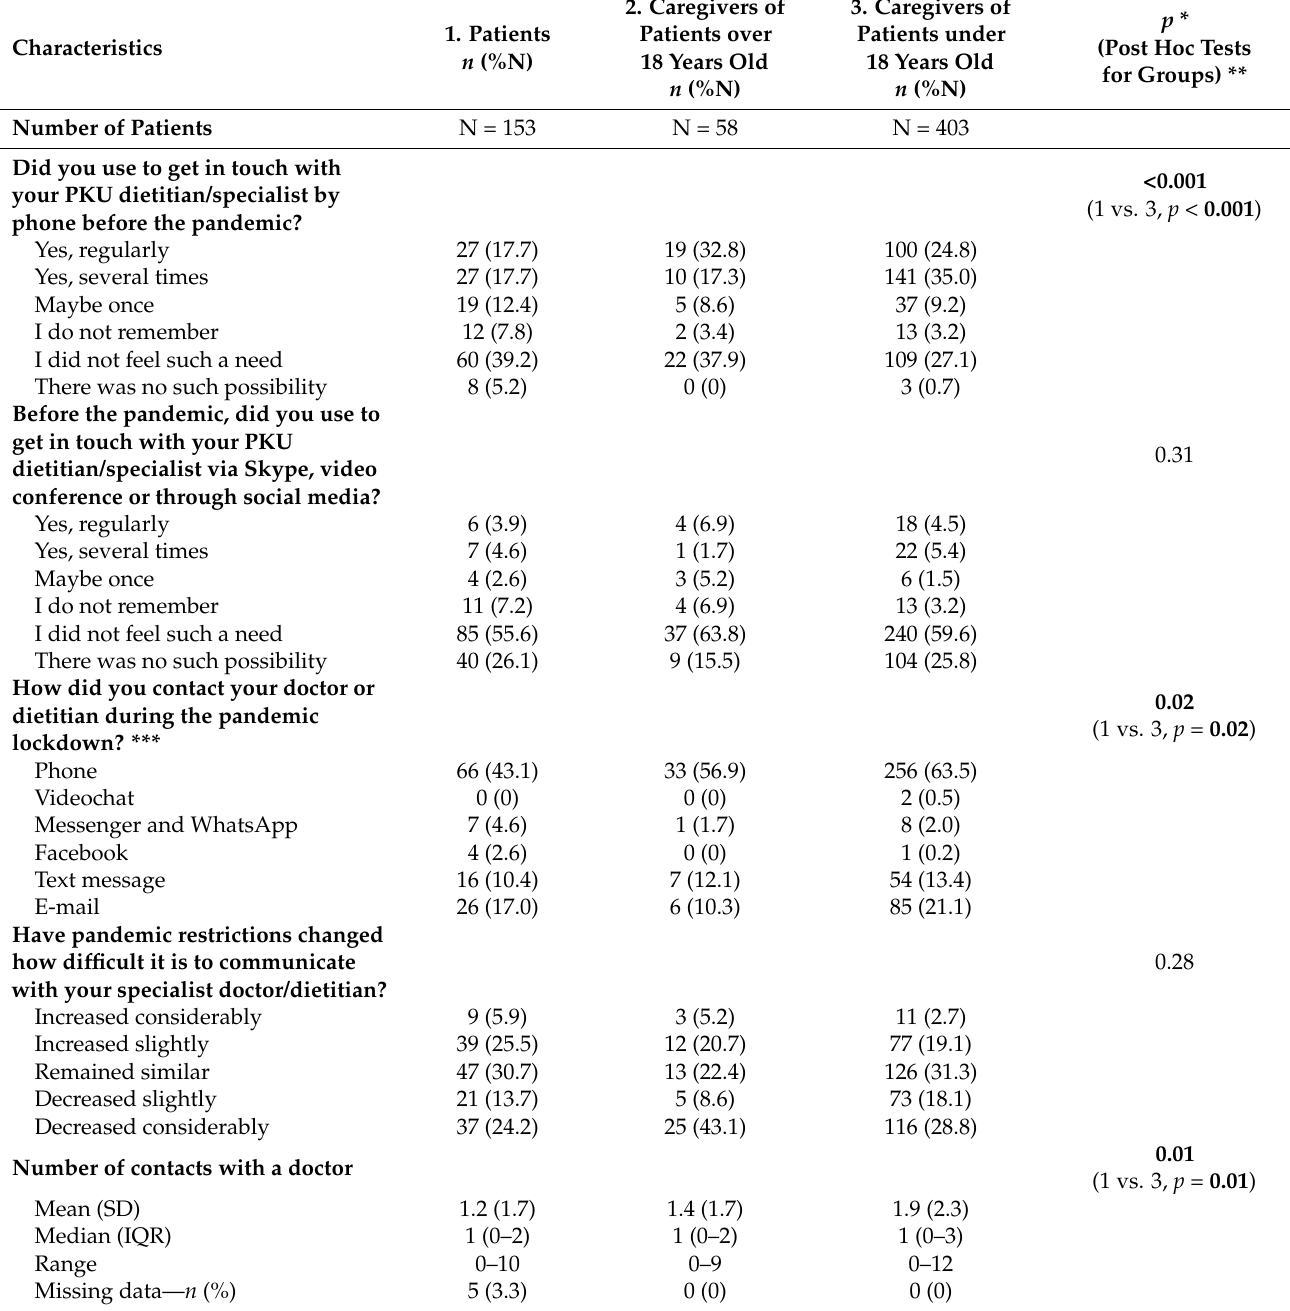
Table 2. Details of contact with a PKU